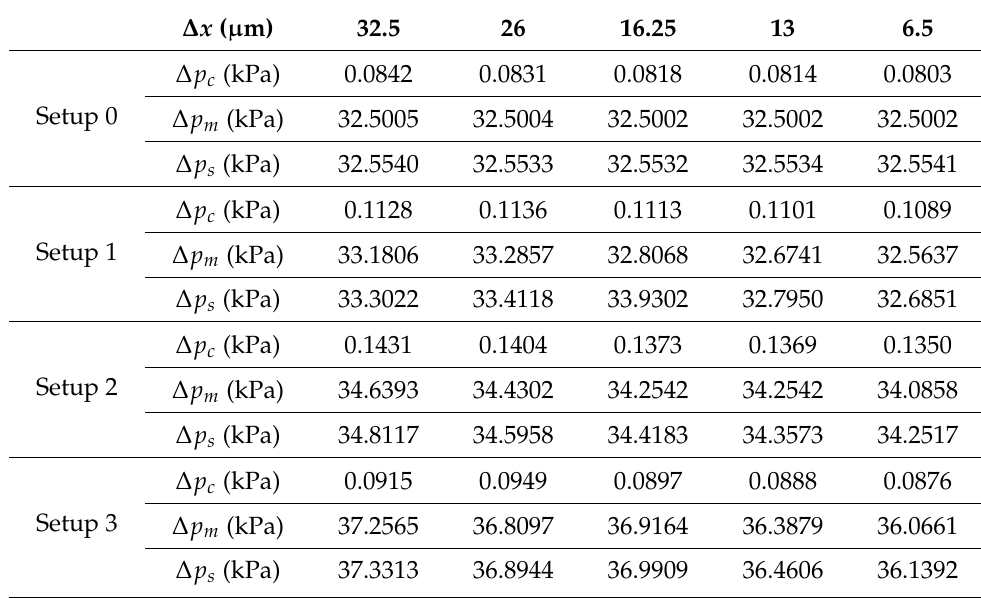
Table 1. Comparison of pressure criteria for different grid